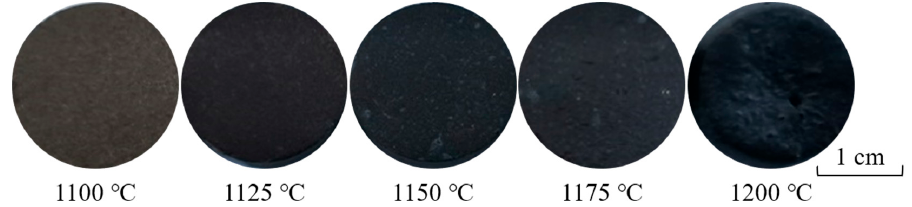
Figure 6. Ceramic tile samples with Fe/Cr = 2.0 sintered at different temperatures for 30 min.